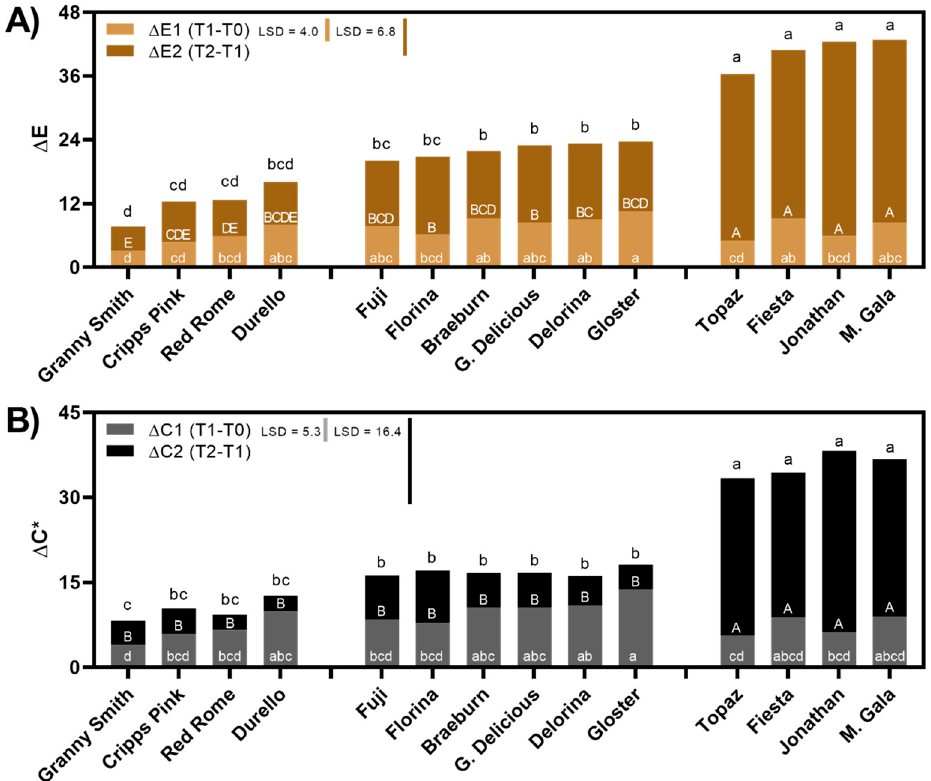
Figure 1. ( A ) Color difference between each time point as Δ E between T1 (1 h from cut) and T0 (cut) and between T2 (24 h from cut) and T1 (1 h from cut) across cultivars. Means are displayed for each time with the sum of Δ E from T2–T0 ( Δ E) stacked in one column. Different black letters above the columns indicate differences according to Tukey post-hoc mean comparison at a p < 0.05 for Δ E (T2–T0) as the total color difference from T0 to T2. LSD determined by Tukey for Δ E1 and Δ E2 are displayed in the top left corner. Letters (in white) inside the columns denote differences in means at Δ E1 (lower-case inside light brown column) and Δ E2 (upper-case inside darker brown columns). ( B ) Chroma difference between each time point as Δ C * (chroma) between T1–T0 and T2–T1 across cultivars. Means are displayed for each time with the sum of Δ C * from T2–T0 ( Δ C 3) stacked in one column. Different letters above the column indicate differences according to Tukey post-hoc mean comparison at a p < 0.05 for Δ C * (T2–T0). LSD determined by Tukey for Δ C 1 and Δ C 2 are displayed in the top left corner. Letters (in white) inside the columns denote differences in means at Δ C 1 (lower-case inside gray columns) as 1 h after cut and Δ C 2 (upper-case inside black columns) as color change in the time between 1 h and 24 h.